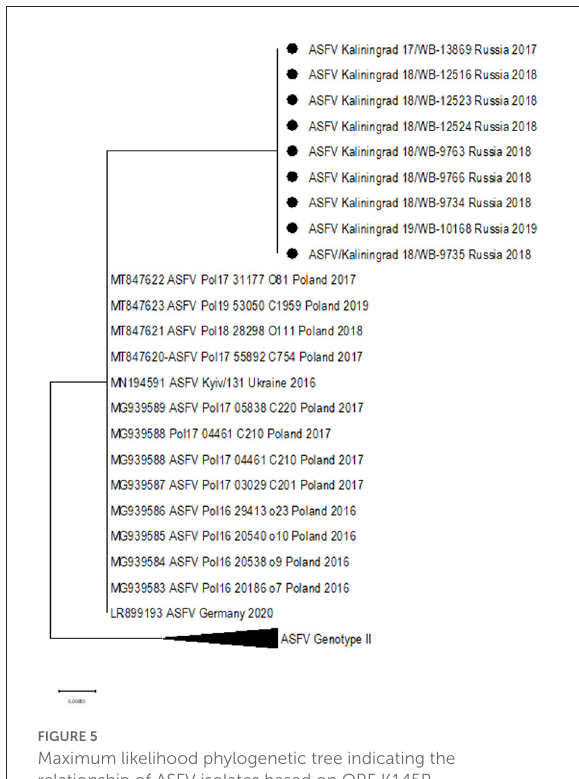
FIGURE5 Maximum likelihood phylogenetic tree indicating the relationship of ASFV isolates based on ORF